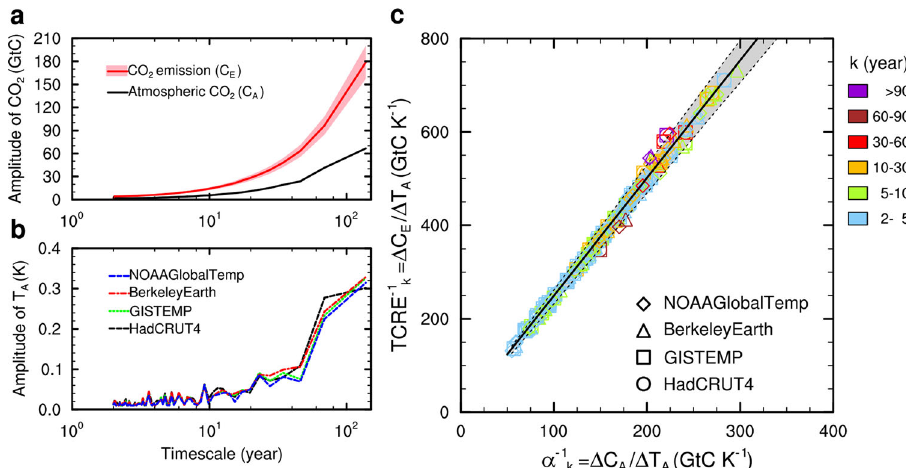
Fig. 2 Linear relationship between 1 α and 1 across timescales. a Amplitude spectrum from Fourier analysis for annual atmospheric CO 2 ( Δ C A ) and TCRE cumulative anthropogenic CO 2 emissions ( Δ C E ) for 1880 – 2017. b Same as ( a ) but for annual global-mean temperature from four observational datasets (HadCRUT4, GISTEMP, Berkeley Earth, and NOAA GlobalTemp) for 1880 – 2017. c Estimates of 1 α ( = Δ C A / Δ T A ) across timescales against 1 for four observational global-mean temperature datasets with atmospheric CO 2 records (or anthropogenic emissions) for 1880 – 2017. The solid line with the shaded area between the dashed lines is the linear regression of all datasets with a slope ( p ) of 2.52± 0.15 ppm ppm − 1 , which indicates that the carbon- concentration feedback parameter β is 3.22 ± 0.32 GtC ppm − 1 .